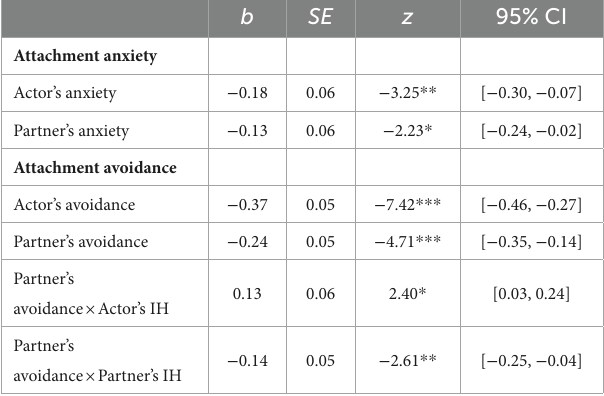
TABLE 2 Effects in the final dyadic